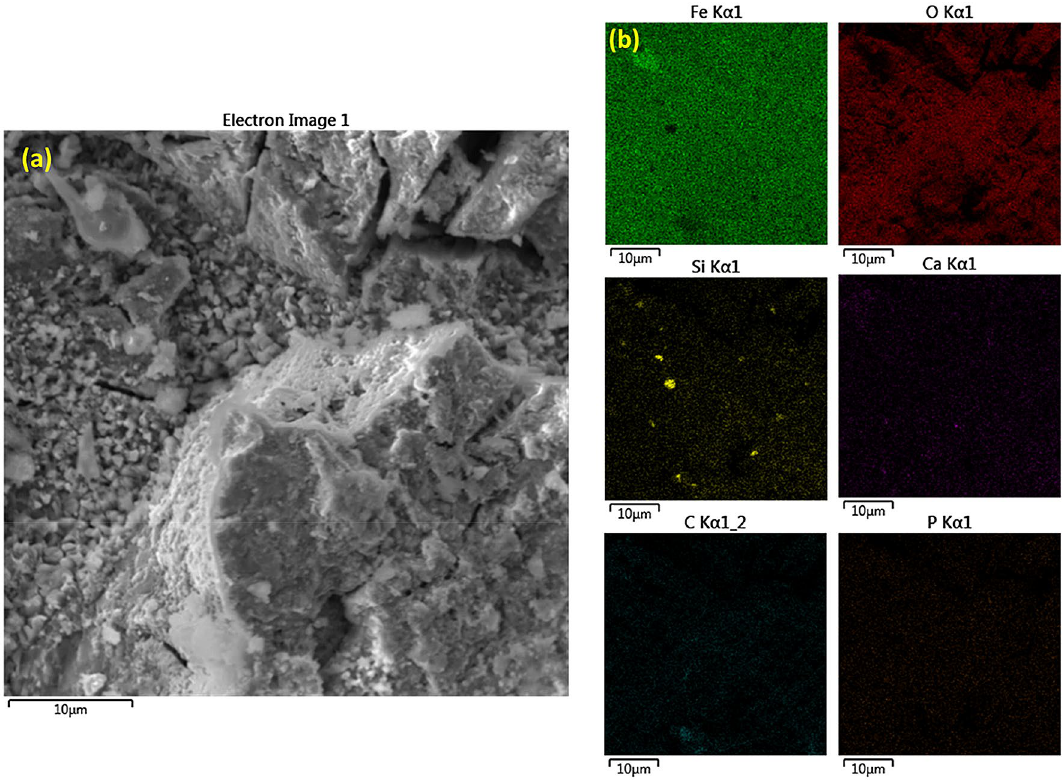
Figure 3. ( a ) FESEM images of corrosion product film formed on the surface of iron made through ancient Indian metallurgical methods ( b ) EDS mapping of Fe, O, C, Si, Ca without P (dots appeared in P mapping are due to instrument